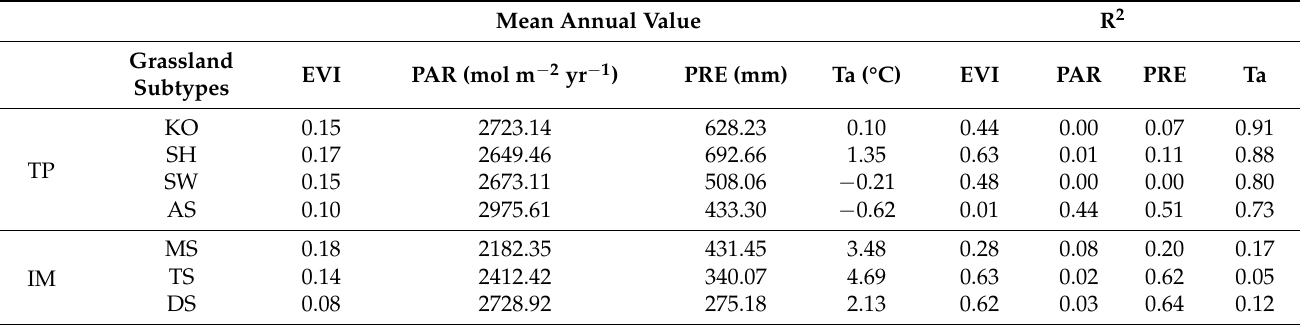
Table 5. The mean annual values for the environmental variables and the interannual dynamic correlation (R 2 ) between RE and the environmental variables in each grassland subtype.